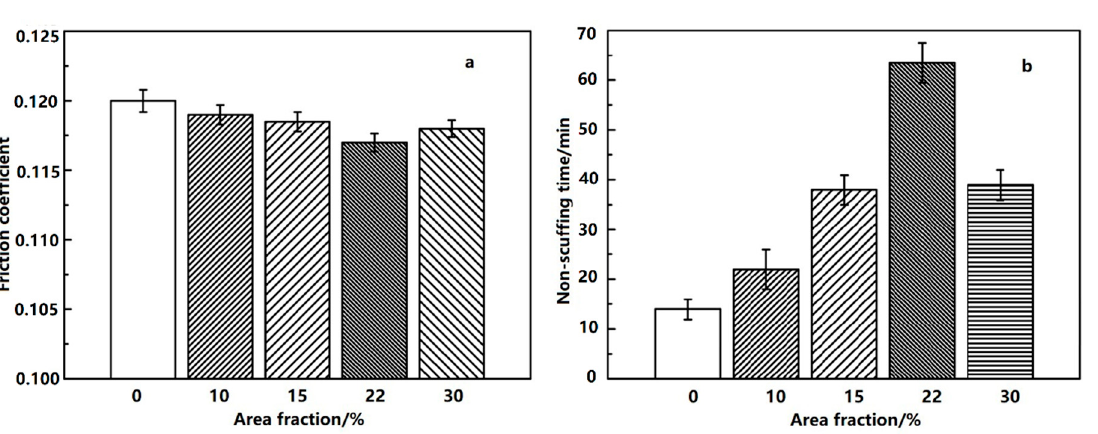
Figure 9. Friction coefficient at the shocking dead center ( a ) and non-scuffing time ( b ) with different area fractions. area